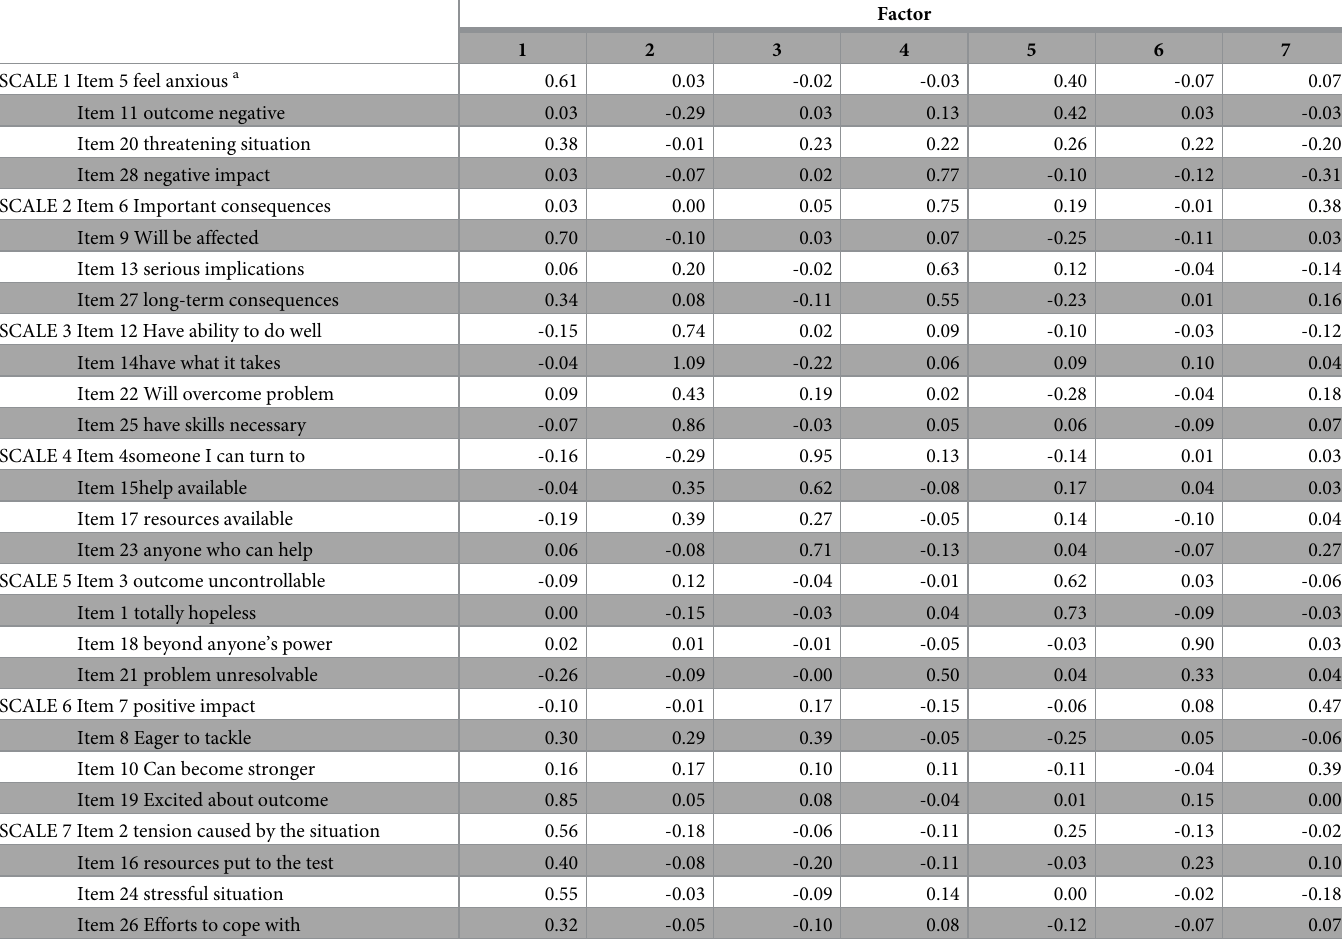
Table 2. Pattern matrix principal axis factoring promax rotation–Items